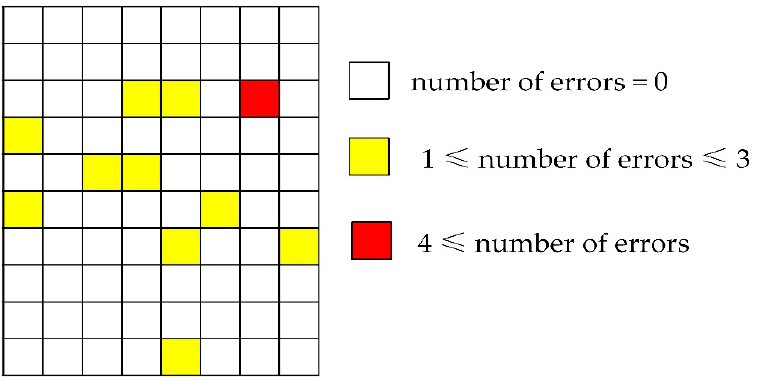
Figure 4. Location and number of errors in one verification.